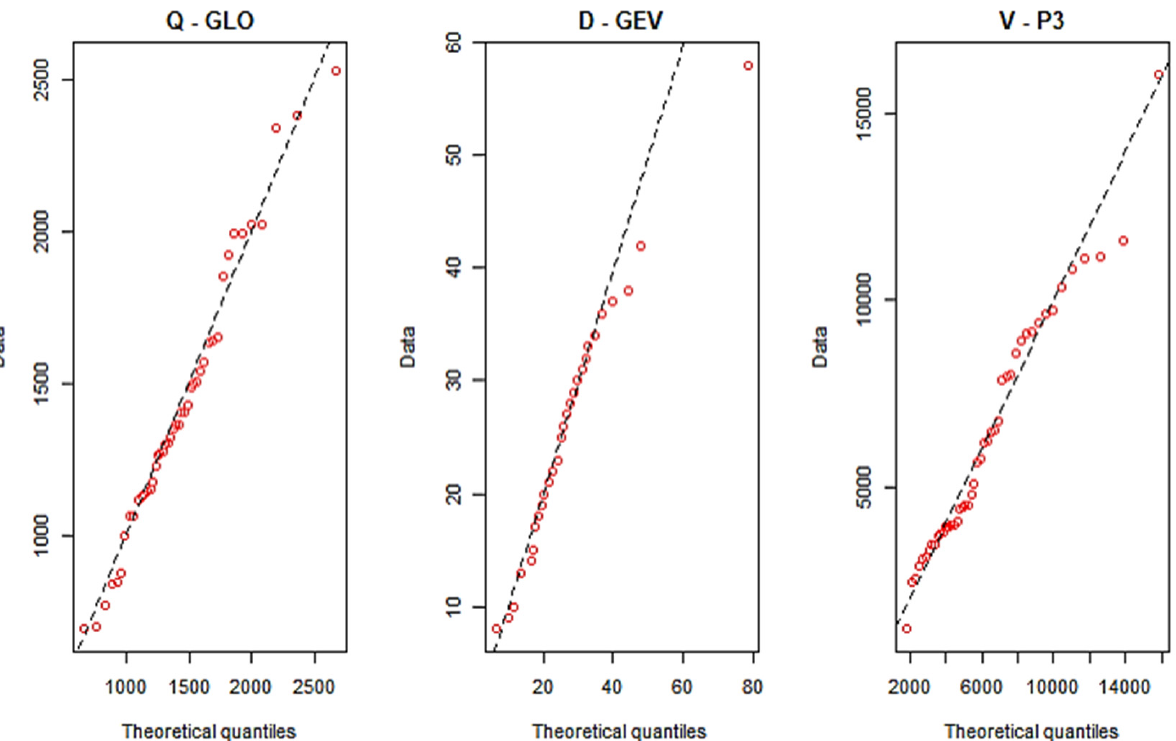
Figure 3. Example of QQ plots for the selected marginal distributions for the Botovo GS on the Drava River.